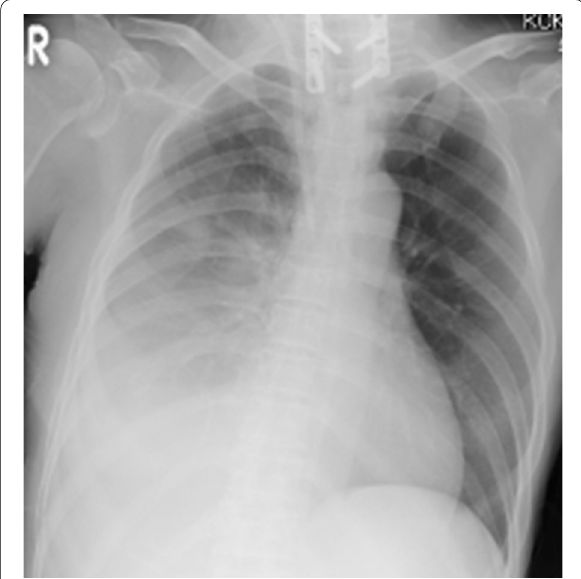
Fig. 1 Chest radiograph taken before surgery shows right